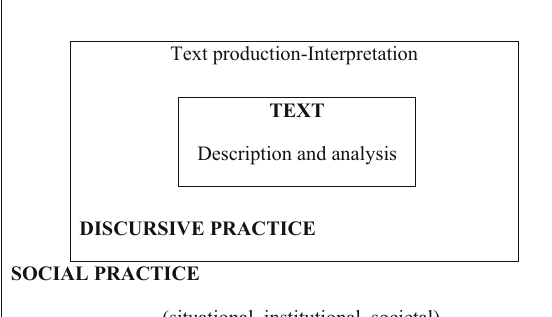
Figure 1: Fairclough ’ s three - dimensional model for critical discourse analysis ( 1992b: 73 )